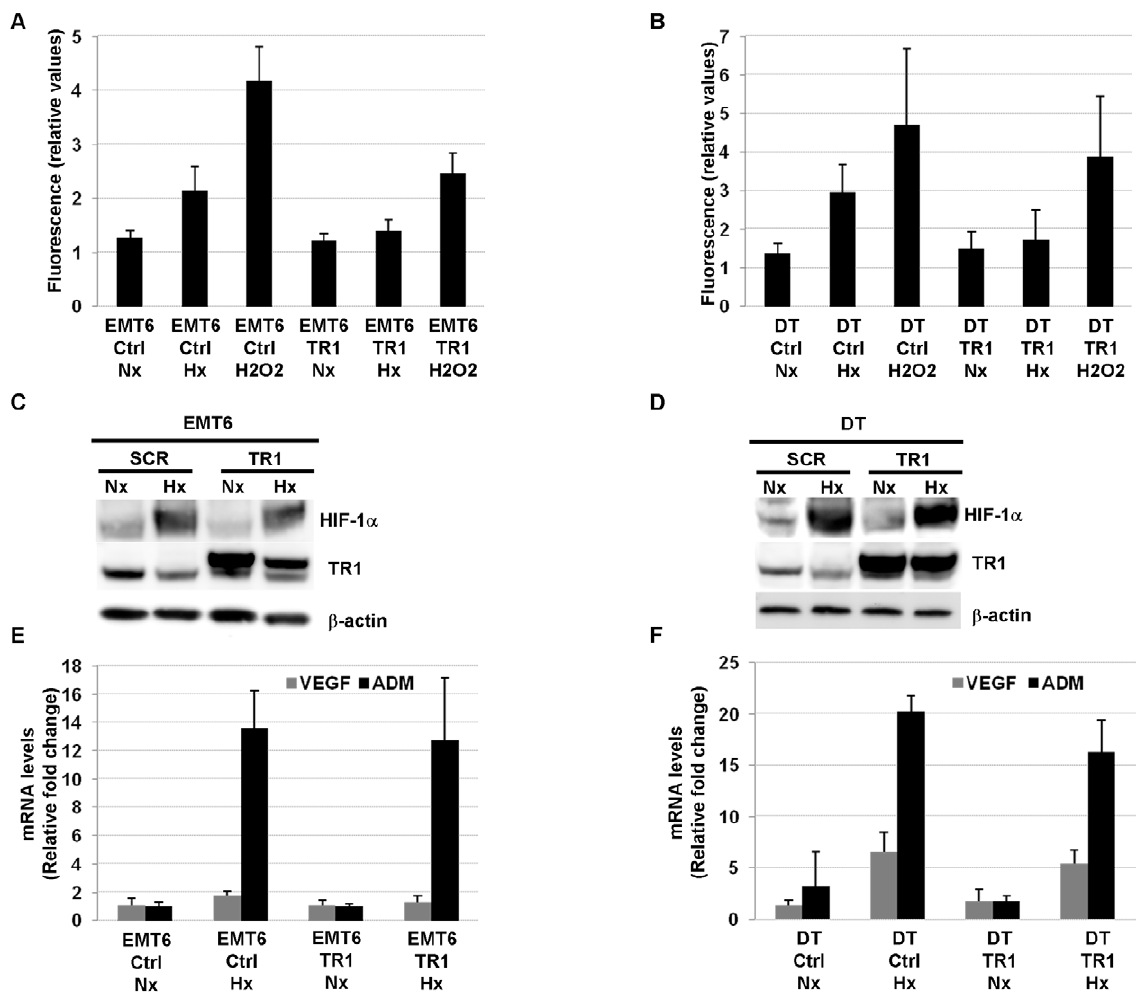
Figure 6. ROS levels and HIF stabilization and activity in hypoxic TR1 over-expressing cells. ROS levels were determined in (A) EMT6 and (B) DT cells infected with retroviruses encoding the TR1 gene (TR1) or empty retroviruses (Ctrl) and cultured under normoxic (Nx) or hypoxic (Hx) conditions for 12 h. Data represent the fluorescence value of each sample after subtracting the fluorescence value from unstained control cells. The mean 6 SE of 4–7 independent experiments is shown. Protein levels of HIF-1 a and TR1 were determined by western blotting in (C) EMT6 and (D) DT cells infected with empty retroviruses (Ctrl) or retroviruses encoding the TR1 gene (TR1) and cultured for 12 h under normoxic (Nx) or hypoxic (Hx) conditions. VEGF and ADM mRNA levels were analyzed by quantitative RT-PCR in EMT6 (E) or DT (F) cell lines with retroviruses encoding the TR1 gene (TR1) or with empty retroviruses (Ctrl) and cultured under normoxic (Nx) or hypoxic (Hx) conditions for 12 h. Data show the means of 3 independent experiments 6 SE.